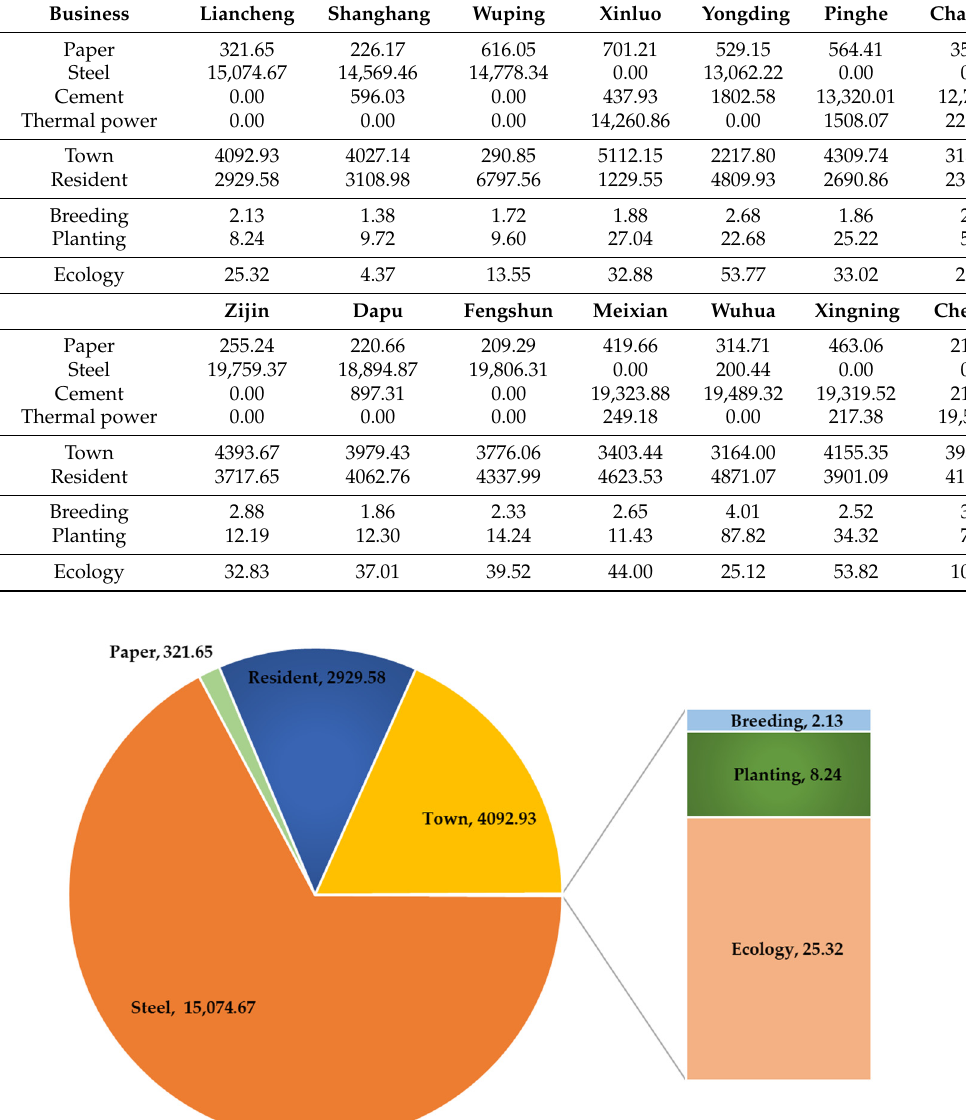
107.52 Figure 3 depicts the second-stage penalty value of water resources in Liancheng County. The absence of penalty values for ecological water in the second stage signifies sufficient ecological water under the five hydrological scenarios and hence cannot be